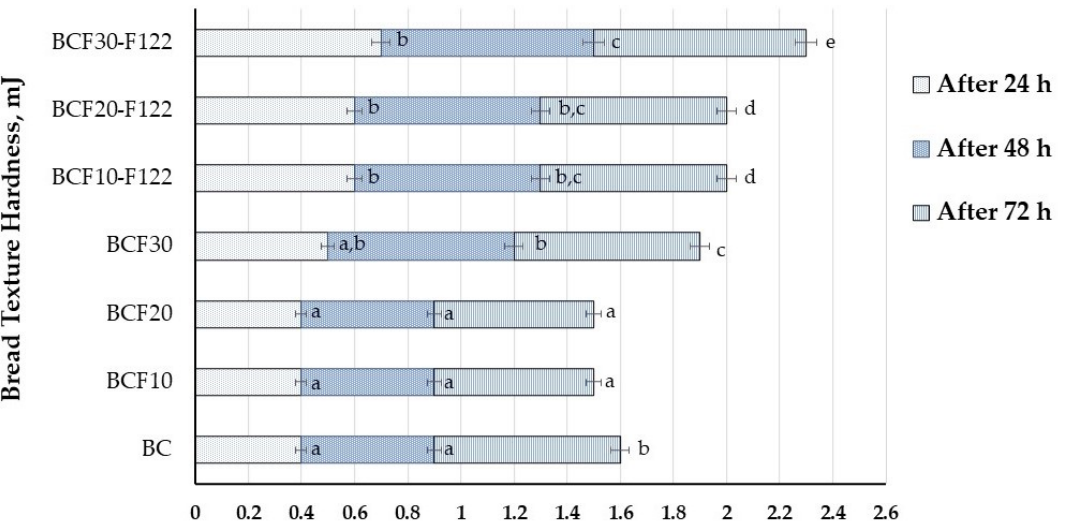
Figure 3. Bread texture hardness (mJ). B C — control bread; B CF10 ; B CF20 ; B CF30 — bread samples with 10, 20, and 30% cricket flour, respectively; B CF10-F122 ; B CF20-F122 ; B CF30-F122 — bread samples with 10, 20, and 30% cricket flour fermented with Lactiplantibacillus plantarum No. 122 strain, respectively. Data are expressed as mean values (n = 3) ± standard error (SE). a – e Mean values within a column with differ- ent letters are significantly different ( p ≤ 0.05).